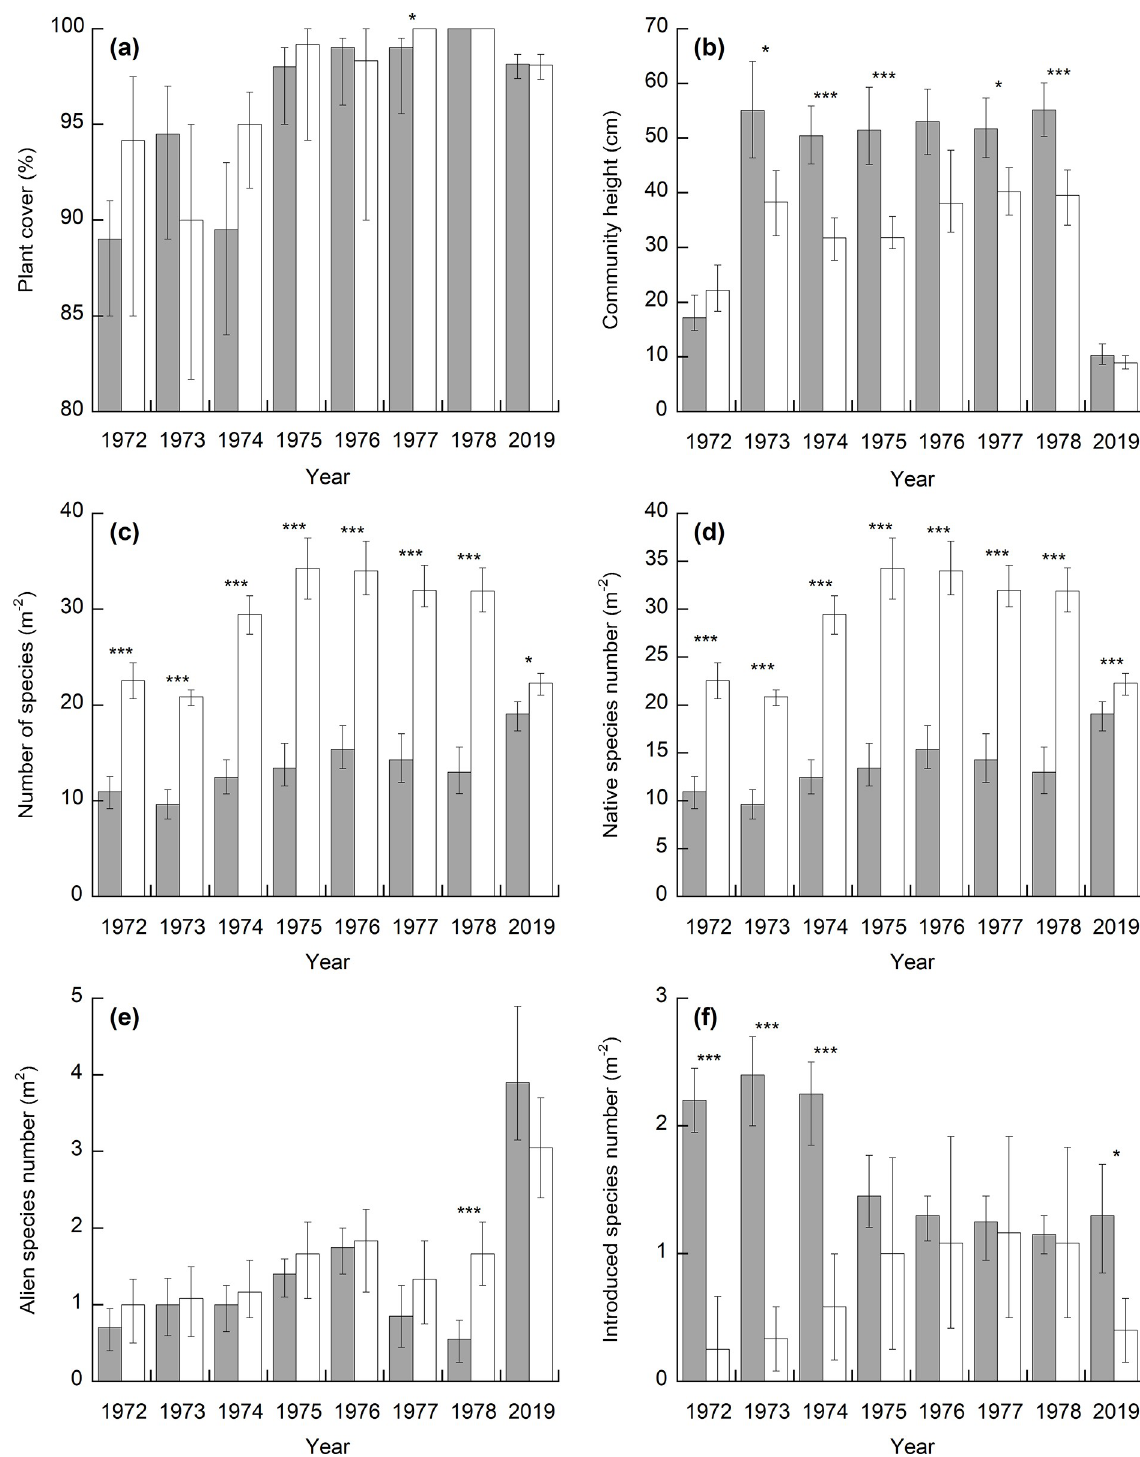
Fig 1. Profile of vegetation in the two pastures. Mean (a) plant cover, (b) community height, and the numbers of (c) all species, (d) native species, (e) alien species other than introduced species, and (f) introduced species per quadrat (m 2 ) in the improved (gray) and native (white) pastures during 1972–1978 and 2019. Error bars indicate 95% bias-corrected accelerated confidence intervals. � p < 0.05, �� p < 0.01, and ��� p <